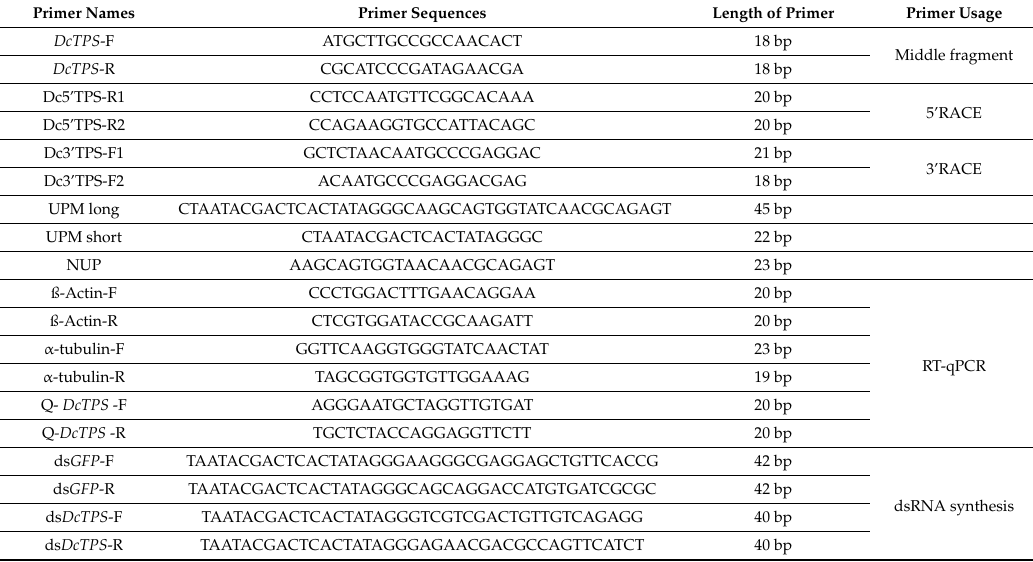
Table 1. Primers used in this